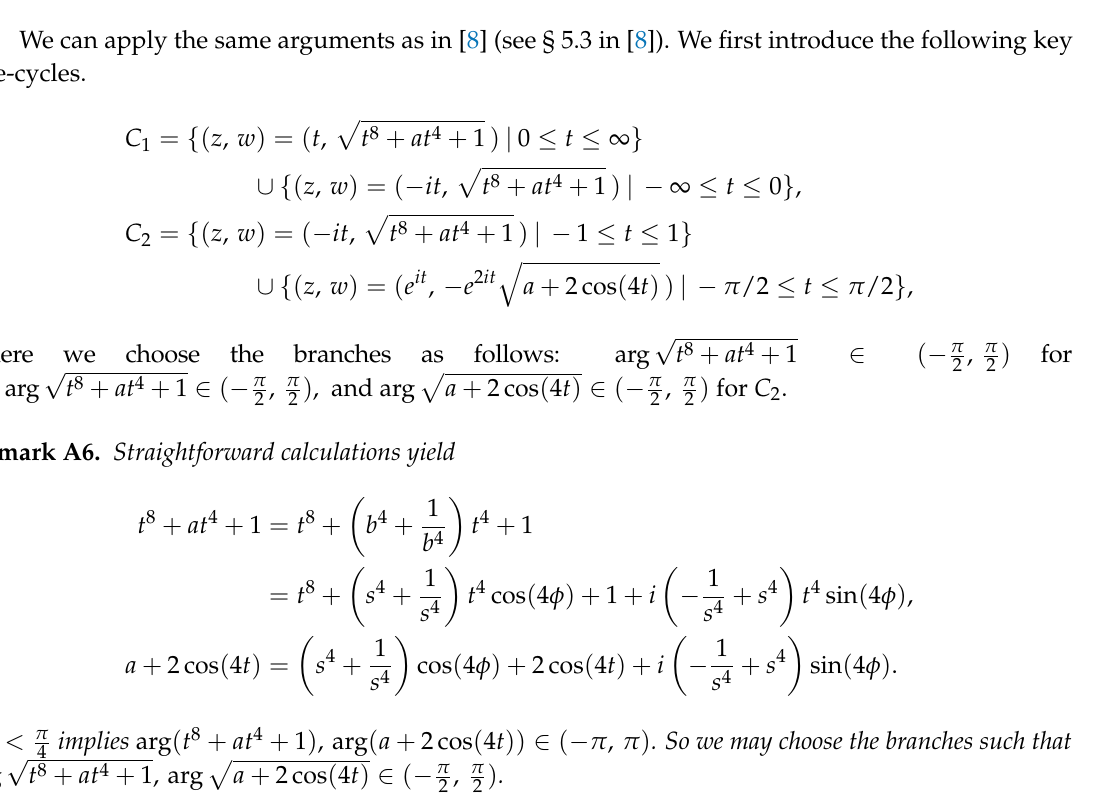
Figure A21. M represented as a two-sheeted branched cover of C